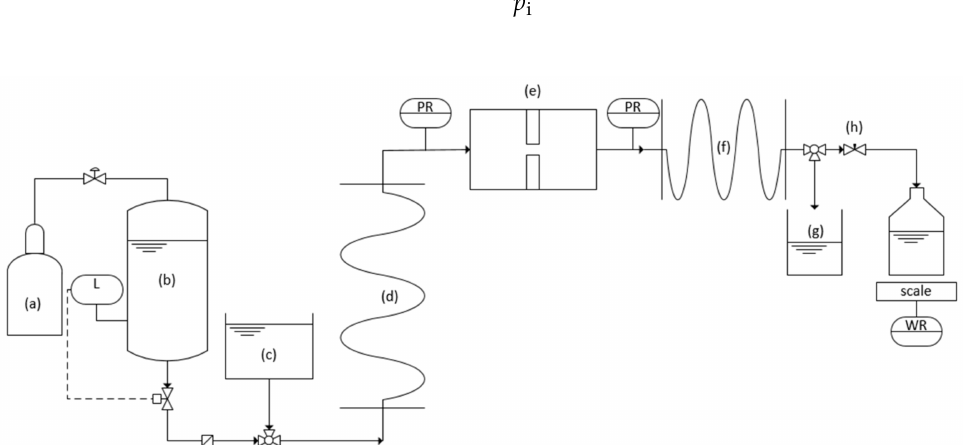
Figure 3. Flow diagram of the experimental setup in original scale (M1): nitrogen gas cylinder ( a ), pressure vessel ( b ), coarse emulsion storage beaker ( c ), pipe coil ( d ), optically accessible orifice ( e ), sample collecting hose ( f ), sample collecting beaker ( g ) and needle valve ( h